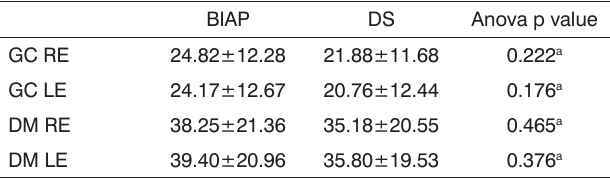
Table 3. Statistical analysis results; audiometric thresholds (dB) mean values and standard deviation, Davis & Silvermann 24 (DS) vs. BIAP 25 , for the two groups - control group (CG) vs. diabetes mellitus group (DM).